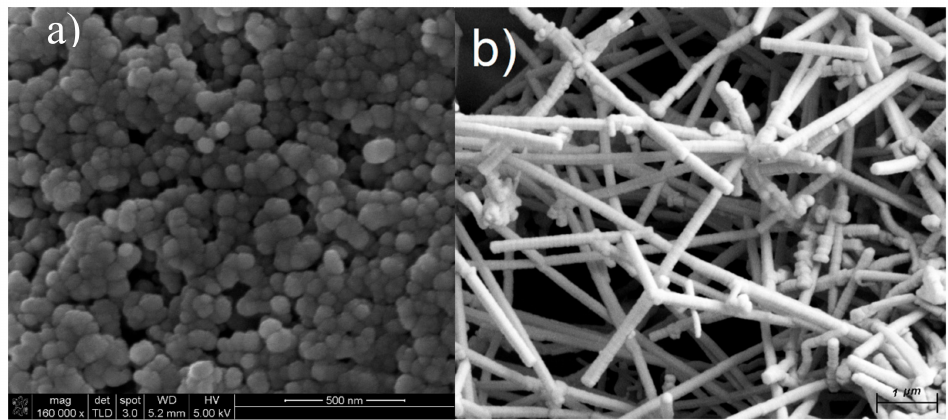
Figure 7. SEM images of ( a ) Al nano-particles and ( b ) Al-Si nano-rods produced from metallized paper annealed at 1500 ◦ C for 60 min.